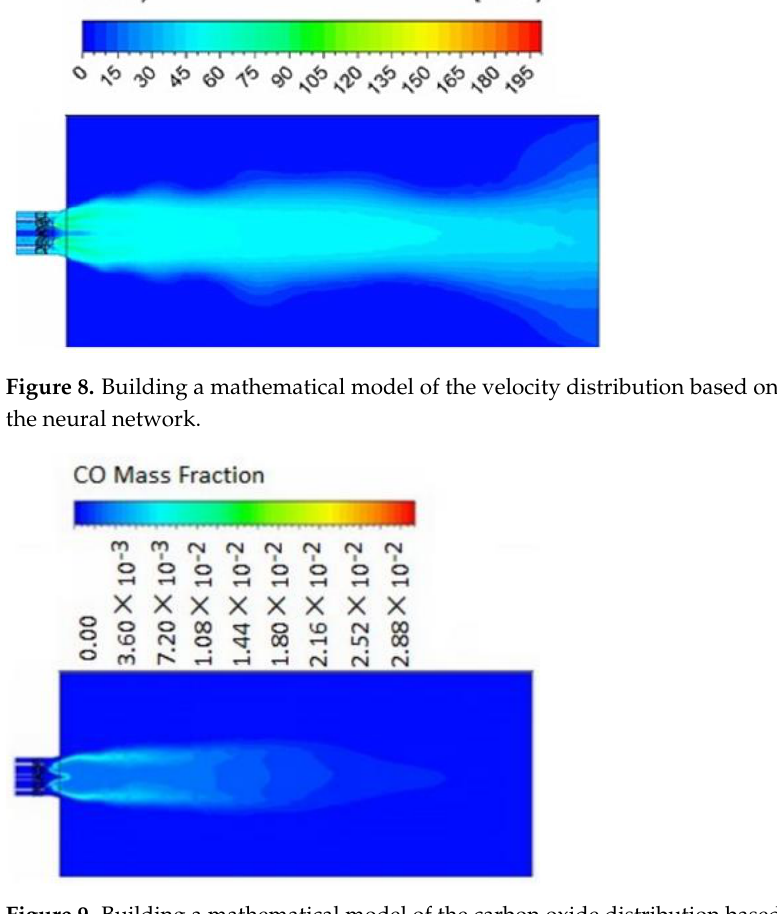
Figure 10. Building a mathematical model of the nitric oxide distribution based on the data col- lected by the neural network. The authors presented the results of mathematical modeling in the ANSYS com- puter environment. The empirical data obtained from similar devices using the devel- oped sampling technology were used as initial conditions. 3.4. Processing of Experimental Results Such methods and mathematical dependencies, as well as experimental data, must pass the verification procedure. To do this, it is proposed to use the error integral: θ(u) = exp(−0.5u 2 )/(2π) 0.5 . (12) In this formula, u is the deviation (standard): u = (x i − ξ)/(ξσ).